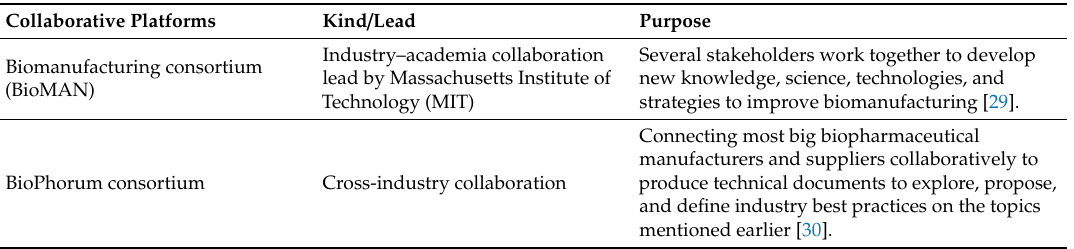
Table 1. Some of the collaborative platforms that enable the development and adoption of new manufacturing technologies such as continuous